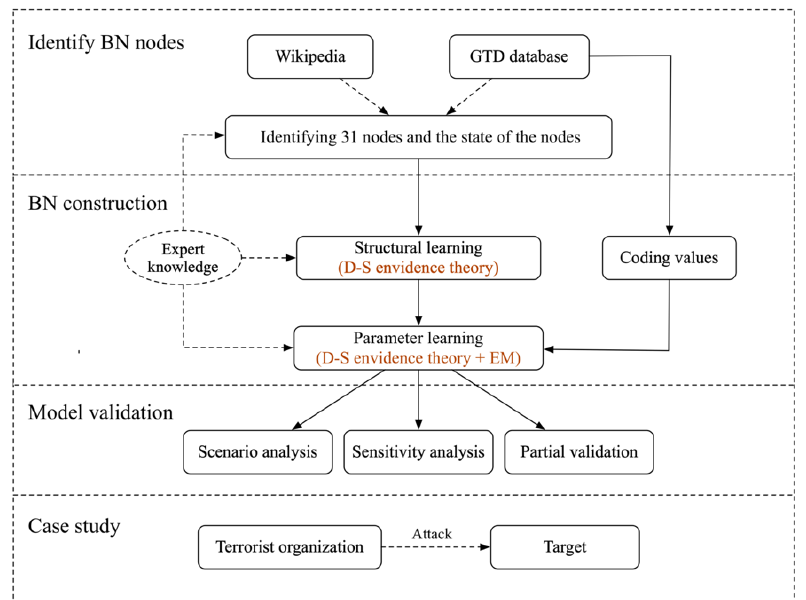
Figure 1. The process flow of framework.